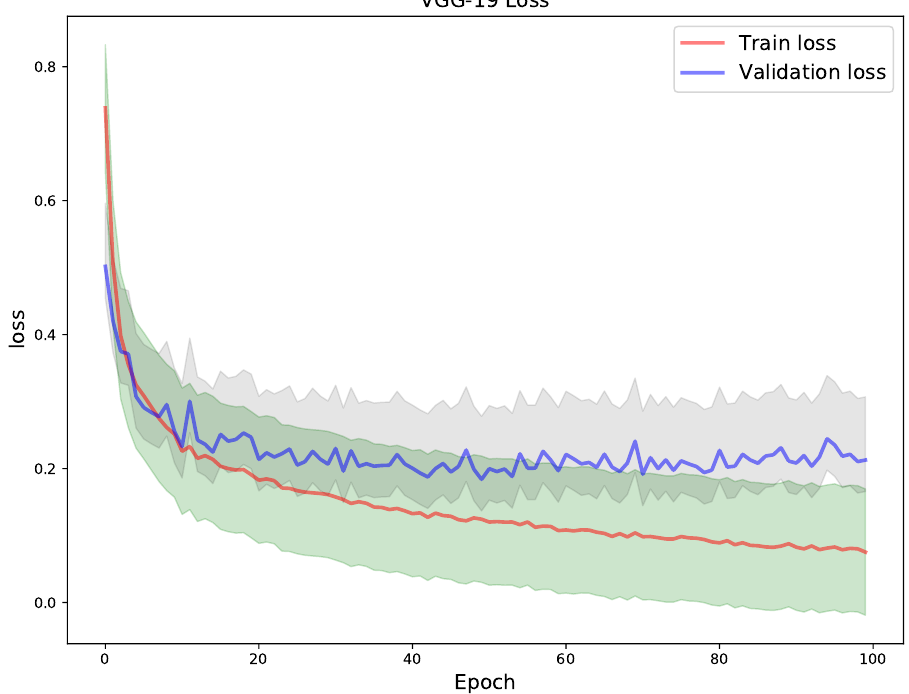
Figure 9. VGG-19 model was trained for 100 epochs. The plot depicts the train vs. validation